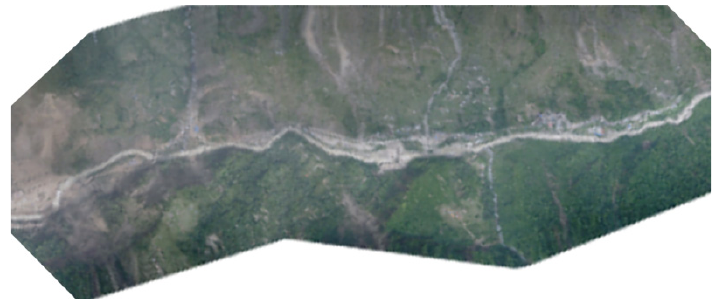
Figure 5. DOM production of the study